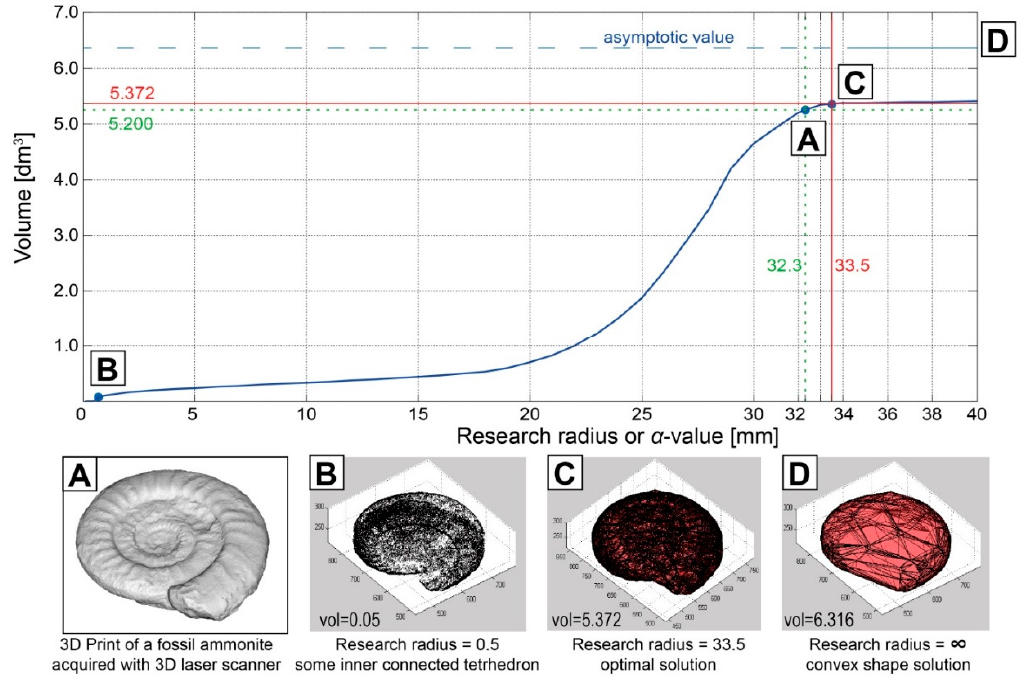
Figure 4. Example illustrating the way to find the optimal research radius that defines the α shape to compute the closer concave hull volume. The results are plotted on a research radius/volume chart. ( A ) Shows the print of a fossil ammonite. ( B ) Point cloud with a small research radius with inner connected tetrahedrons. ( C ) Shows the optimal research radius defined by the flexure of the curve. ( D ) Results with infinite radius leading to the convex hull.